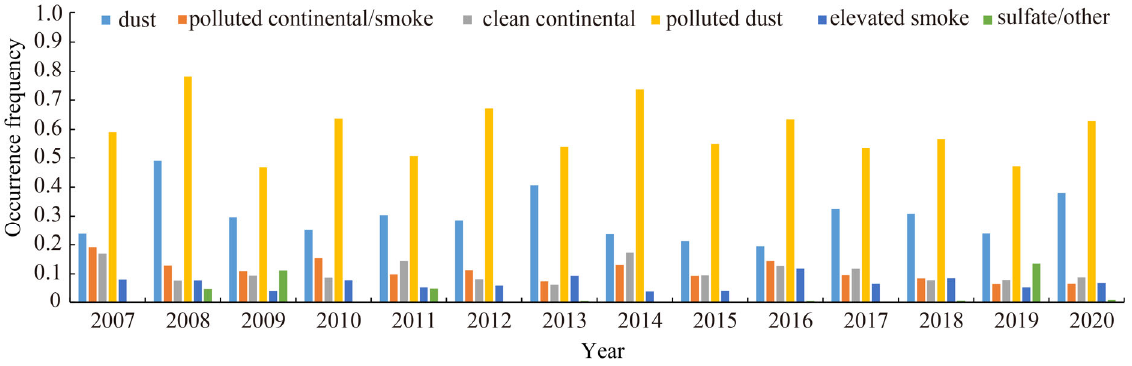
Figure 3. Change in the occurrence frequency of aerosol subtypes from 2007 to 2020.